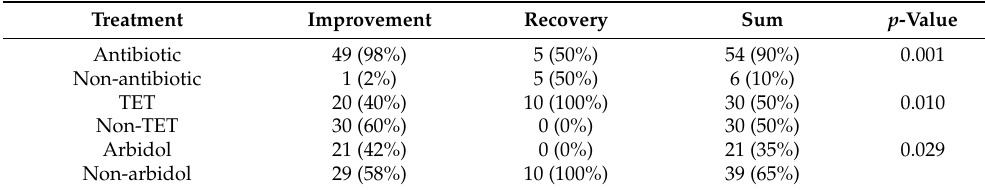
Table 2. Effect on outcome of treatment with antibiotic, tetrandrine, and arbidol of total